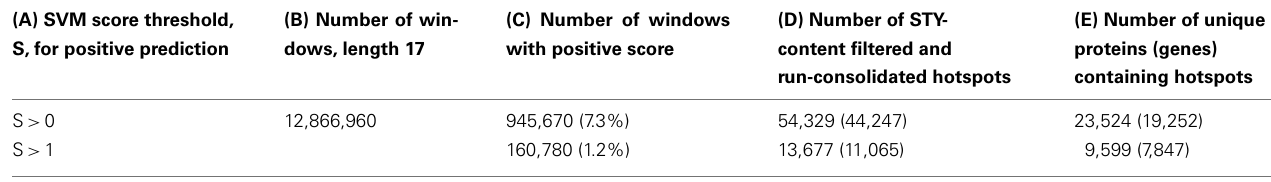
Table 3 | Statistics of HotSPotter predictions in the Arabidopsis